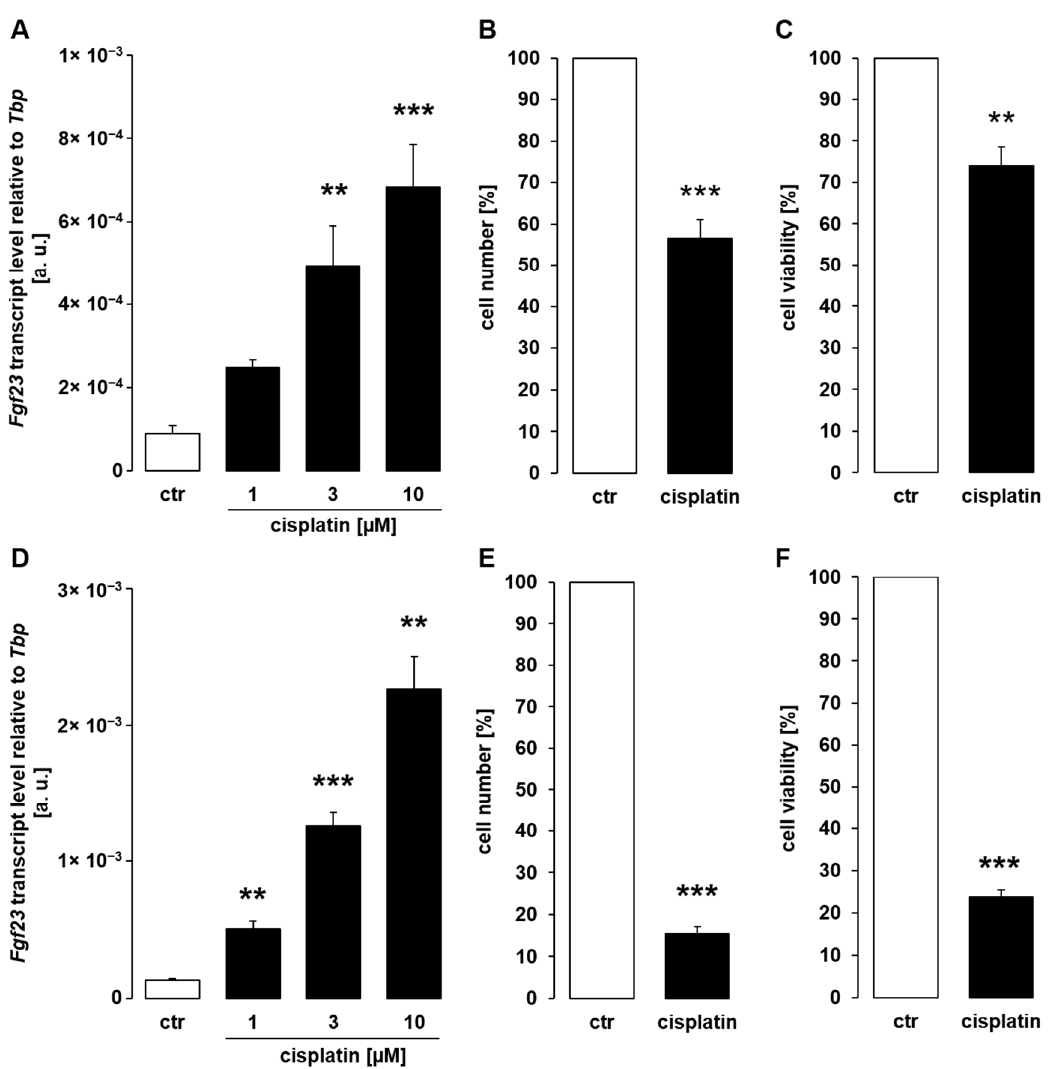
Figure 1. Cisplatin induced fibroblast growth factor 23 ( Fgf23 ) expression in UMR106 cells. ( A , D ): Arithmetic means ± SEM of Fgf23 transcript abundance relative to TATA-binding protein ( Tbp ) in UMR106 cells treated with vehicle control (ctr) or cisplatin at the indicated concentrations for 24 h (( A ), n = 6; ANOVA followed by Dunnett’s multiple comparison test) or 48 h (( D ), n = 6; one-way ANOVA followed by Dunnett T3 multiple comparison test). ( B – F ): Arithmetic means ± SEM of the number (( B ); n = 7; one-sample t -test; ( E ), n = 6; one-sample t -test) or viability (( C ); n = 6; one-sample t -test; ( F ); n = 5; one-sample t -test) of UMR106 cells treated without or with 10 µ M cisplatin for 24 h ( B , C ) or 48 h ( E , F ). All values are relative to the respective values of vehicle-treated cells. ** p < 0.01, *** p < 0.001 indicate significant difference from control cells. a. u., arbitrary units; ctr,